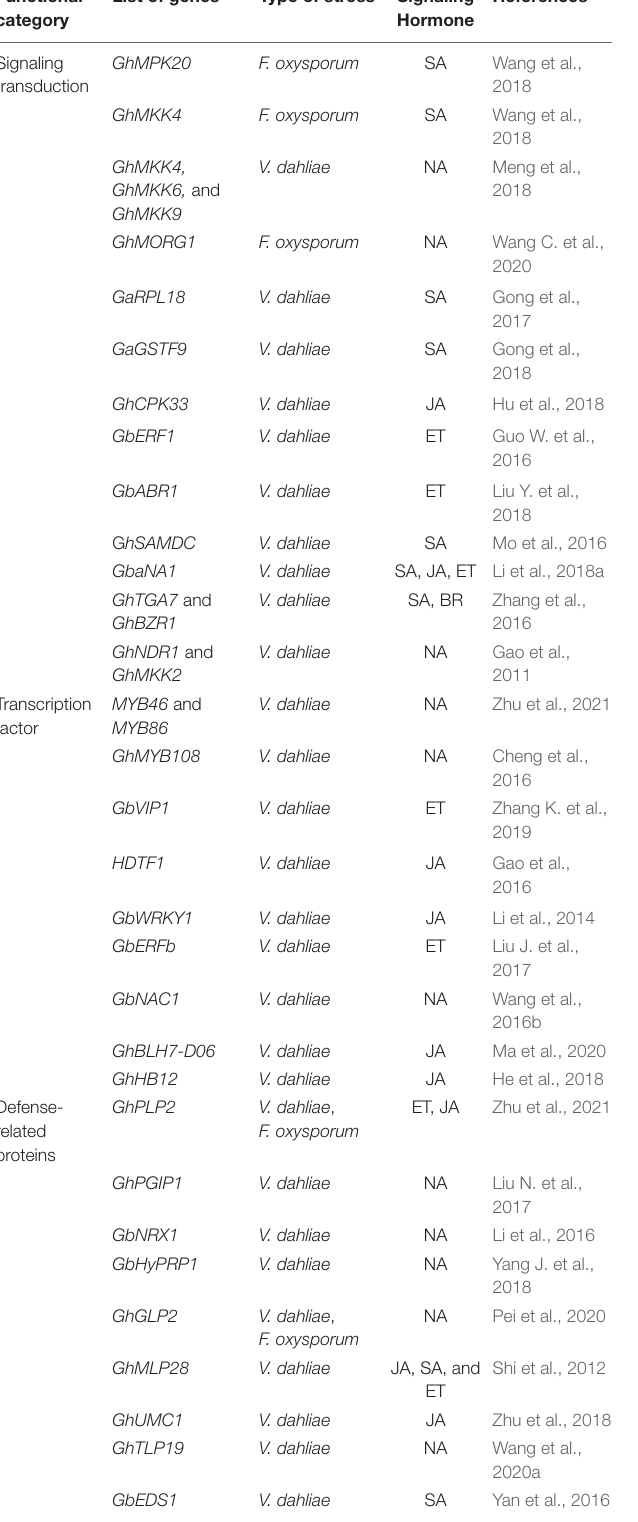
TABLE 2 | Summary of cotton genes regulatory networks in response to Verticillium and Fusarium wilt disease. Functional